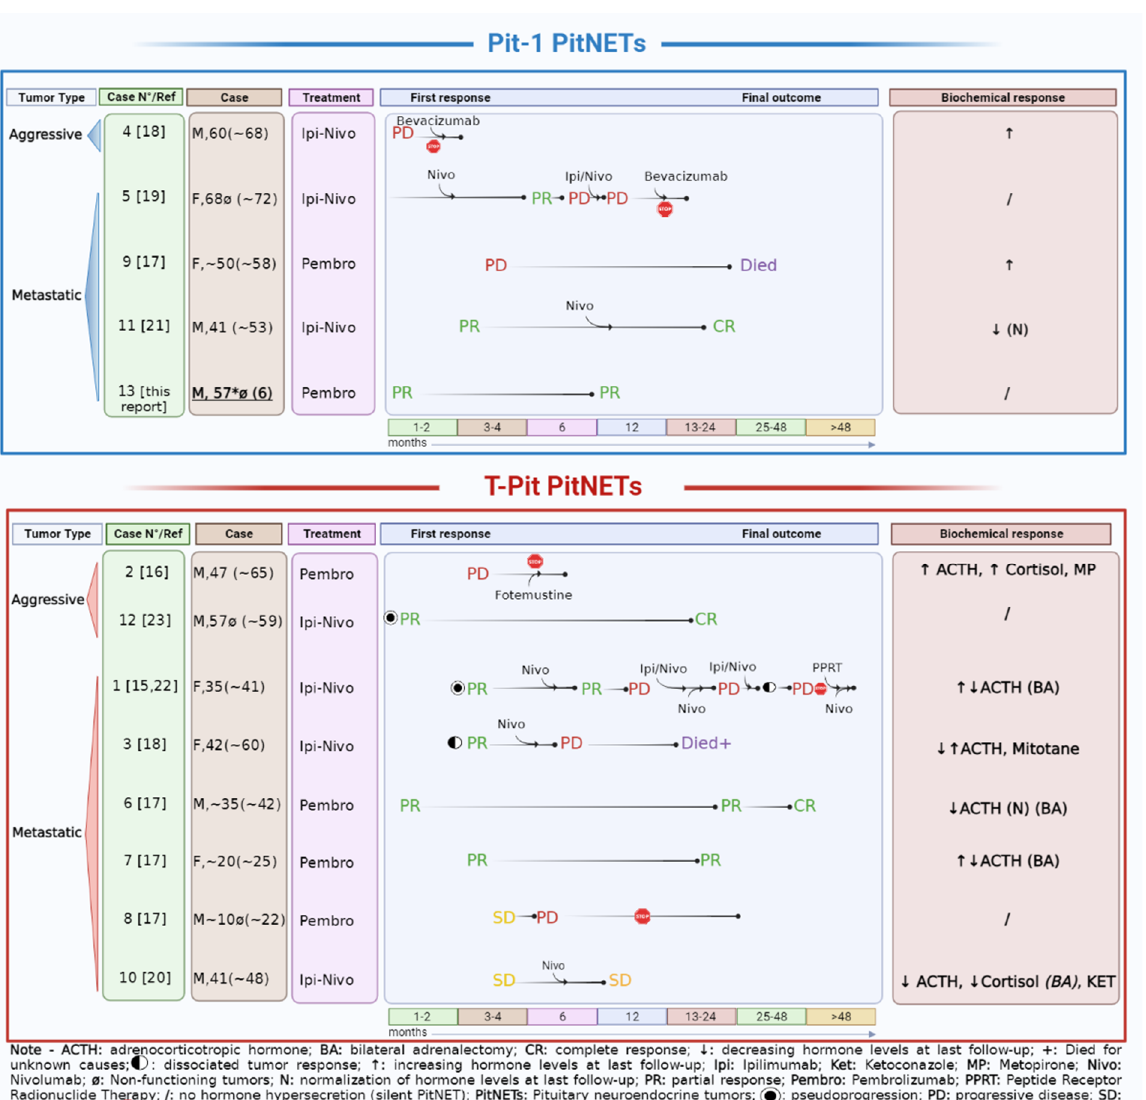
Figure 5. Graphical representation of the current experience with immune checkpoint inhibitors (ICIs) in refractory PitNETS including the new silent Pit1-positive metastatic PitNET reported herein. Created by Biorender [15–23].